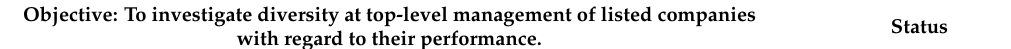
Figure 4. Interaction Effect (Gender Diversity × Foreign Participation Ratio).